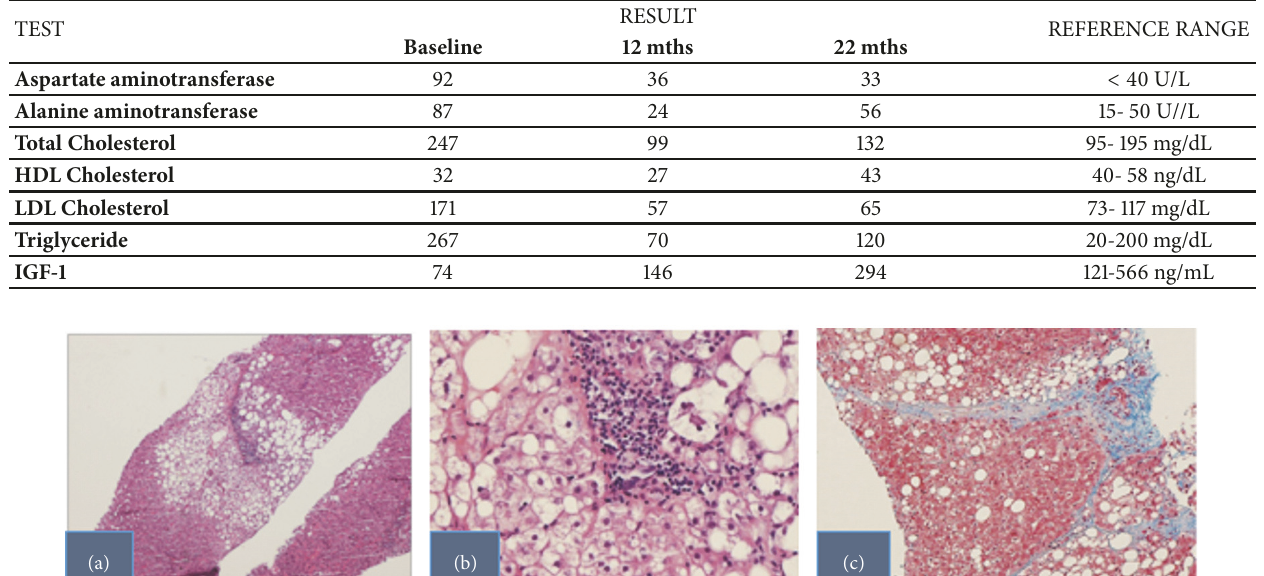
These hyperintense lesions like the initial ones were located in the liver’s parenchyma and the appearance of the liver was otherwise normal.